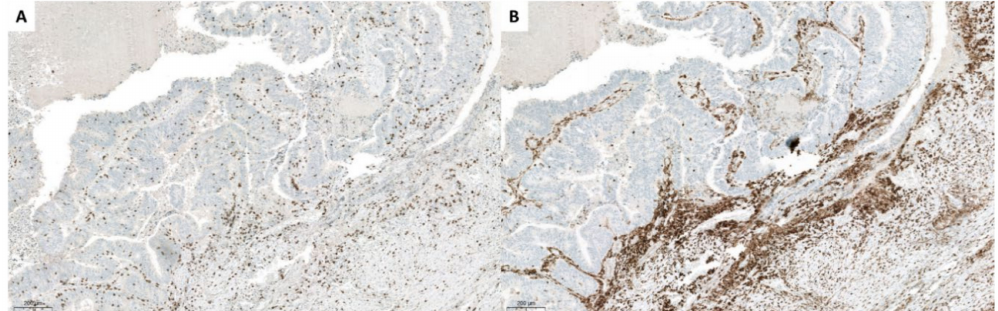
Figure 5. Histologic presentation of a resection specimen of the second patient with colon carcinoma where there are less CD8 ( A ) compared to CD4 ( B ) positive